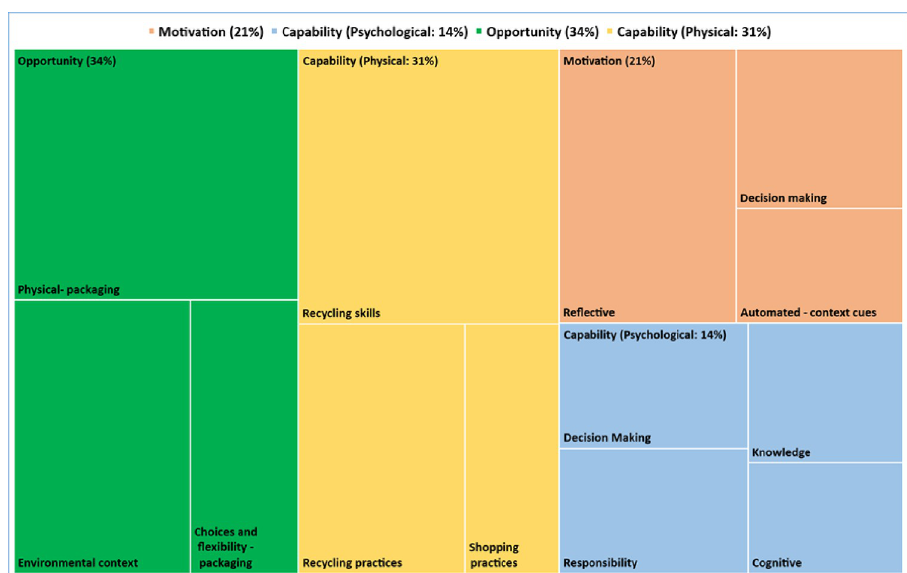
Fig 1. A breakdown of the coding content relating to each domain, using Nvivo—according to COM-B framework.